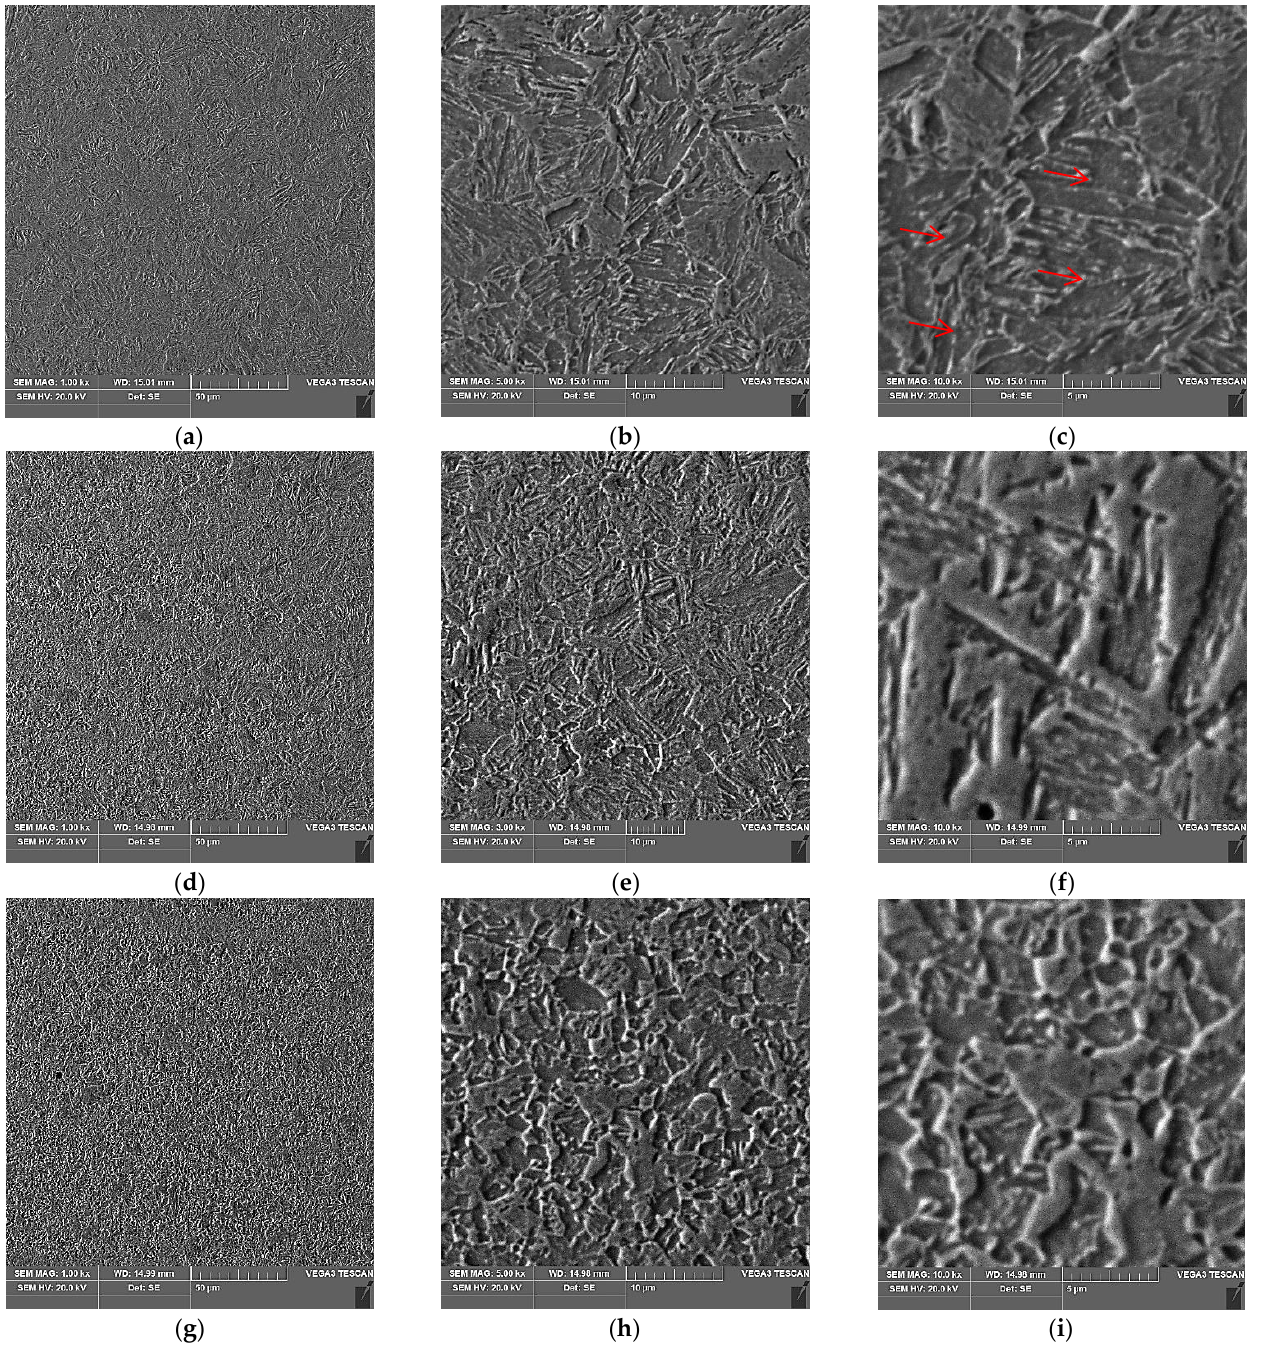
Figure 7. Microstructure of the welded joint in the following characteristic areas: ( a – c ) base material; ( d – f ) weld; ( g – i ) HAZ. The red arrows indicate an example dispersive carbide and carbide – nitride precipitates.